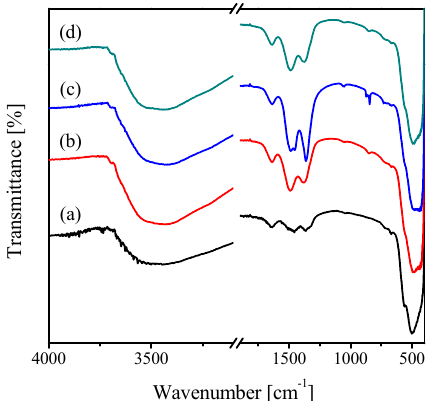
Figure 3. FT ‐ IR spectra of the calcined Ni ‐ oxalate. ( a ); Gd/Ni ‐ oxalate ( b ); La/Ni ‐ oxalate ( c ); and Sm/Ni ‐ Figure 3. FT-IR spectra of the calcined Ni-oxalate. ( a ); Gd/Ni-oxalate ( b ); La/Ni-oxalate ( c ); and oxalate ( d ). Sm/Ni-oxalate ( d